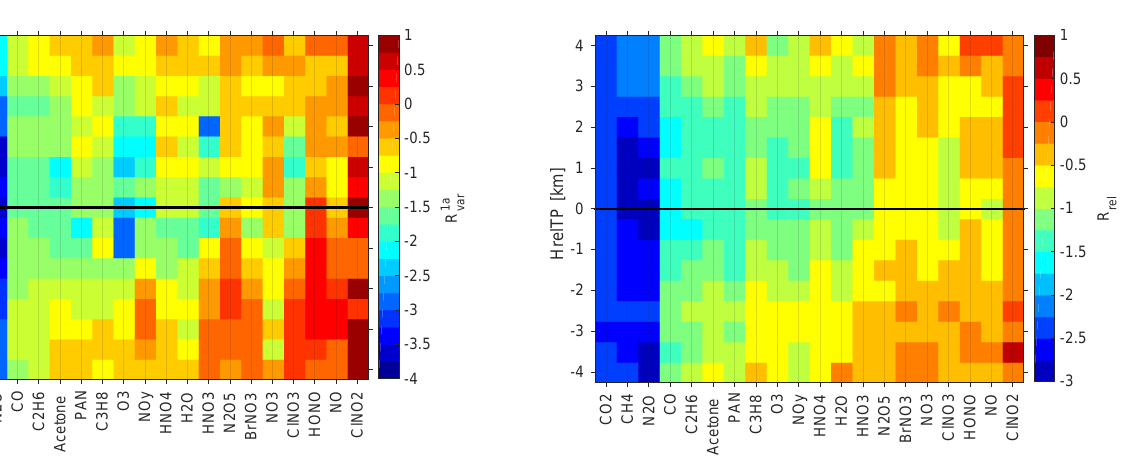
Figure 8. R rel calculated according to Eq. (6) for all species in all and height bins, using MOD regular and MOD RANDPATH . Low values CARIBIC CARIBIC indicate small differences in climatological mean